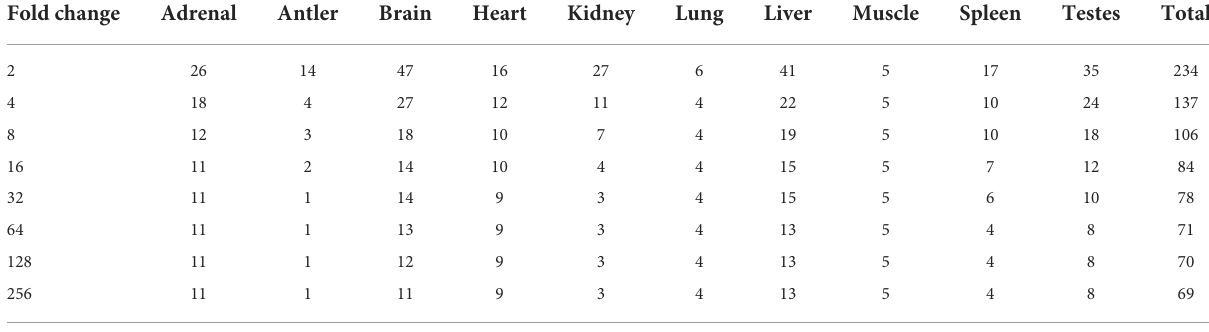
TABLE 1 The number of organ-enriched miRNAs based on fold change.